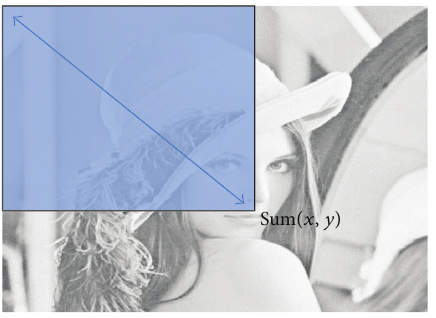
Figure 3: Integral image